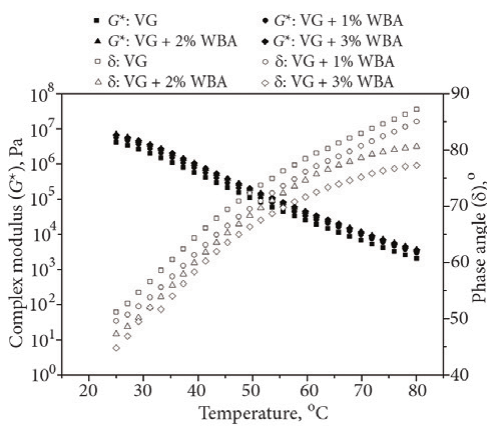
Figure 5. G* sinδ results at 28 °C